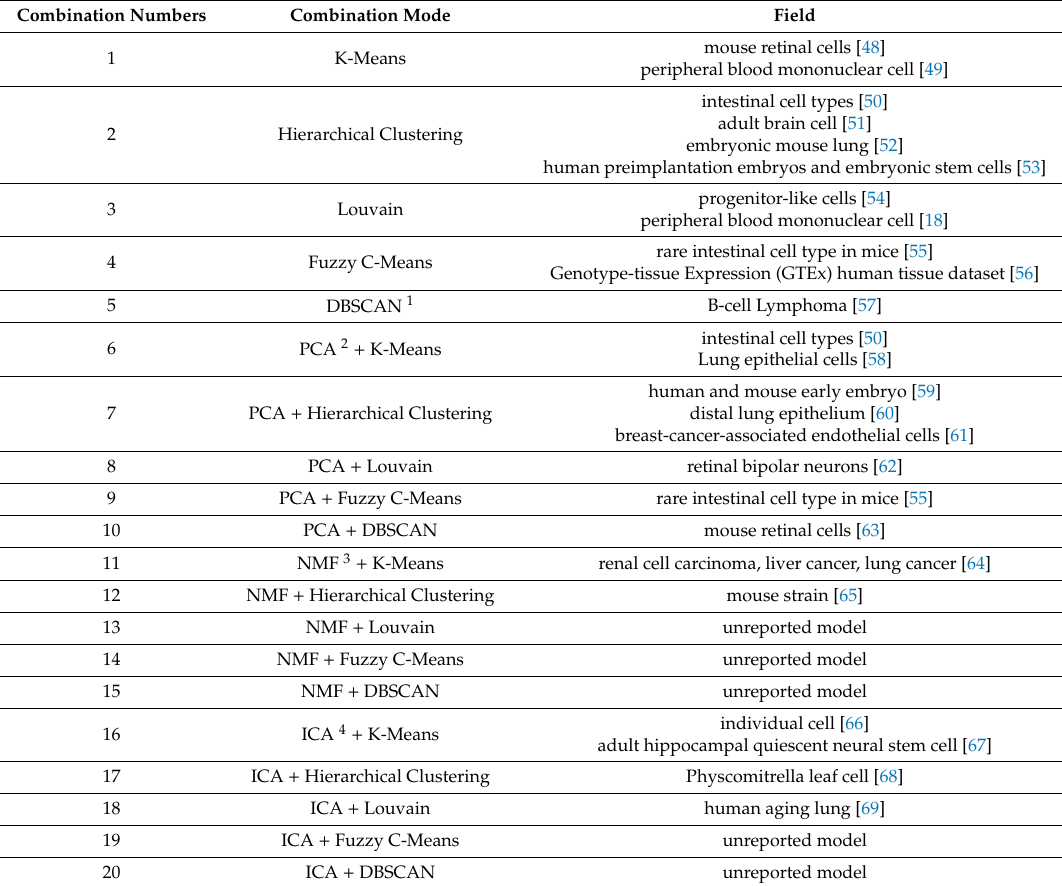
Table 2. Combinations of dimensionality reduction and clustering